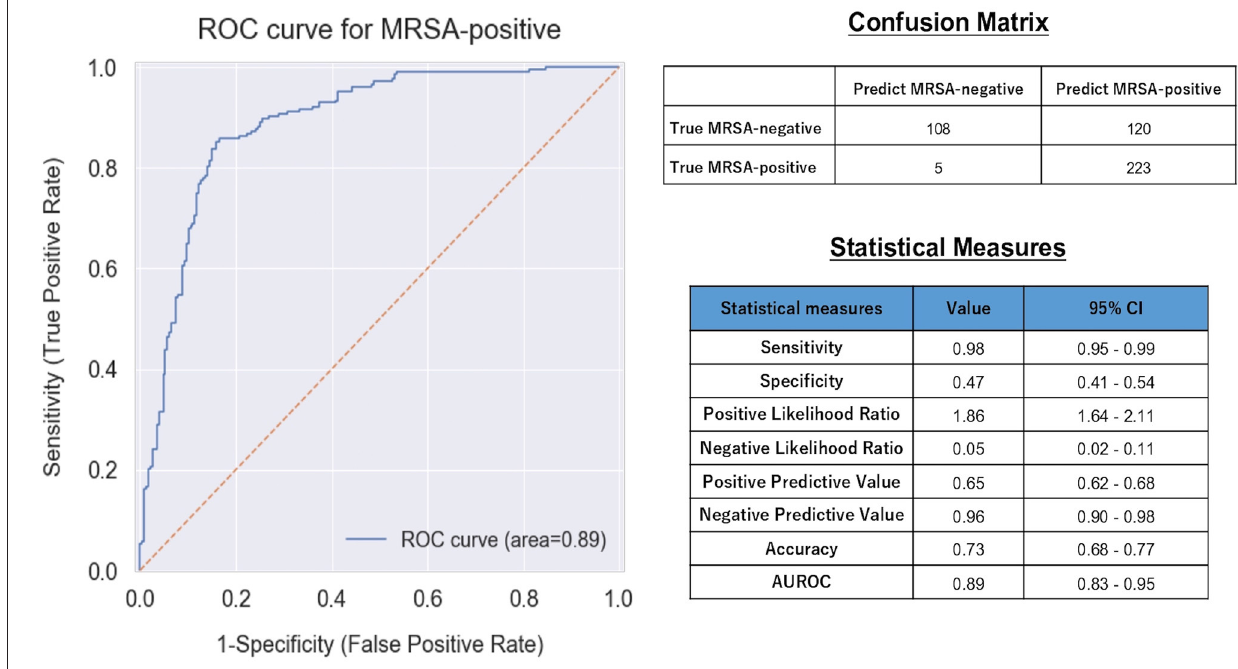
FIGURE 2 | ROC curve, confusion matrix, and statistical measures of performance of the machine learning model. MRSA, Methicillin-Resistant Staphylococcus aureus ; CI, Confidence interval; AUROC, Area Under the Receiver Operating